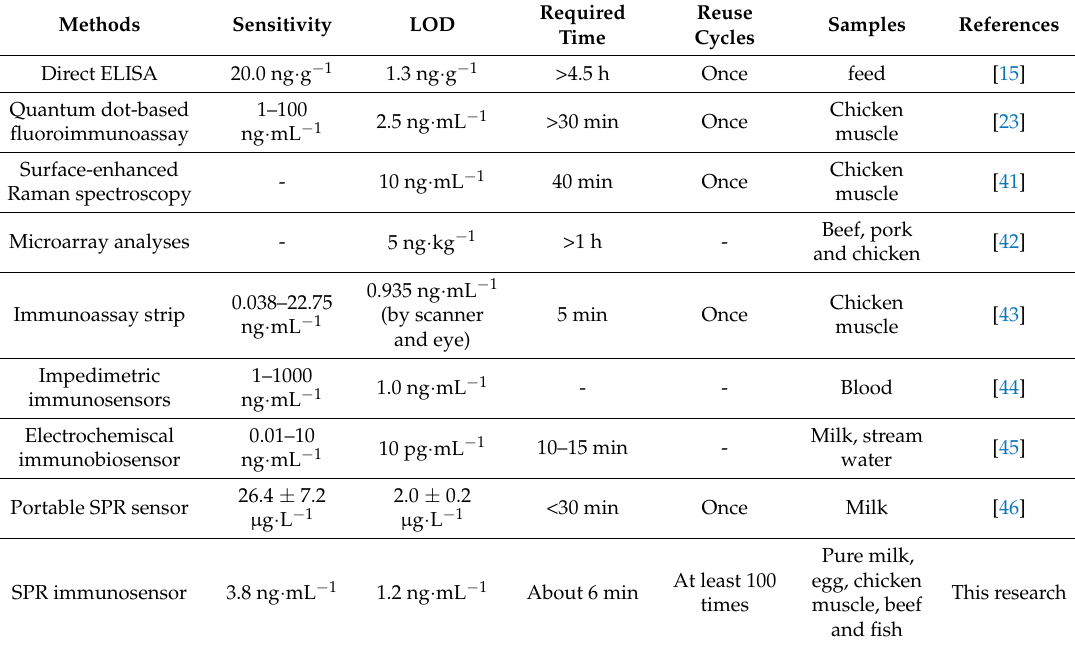
Table 2. Comparison of different methods for ENRO determination in various samples